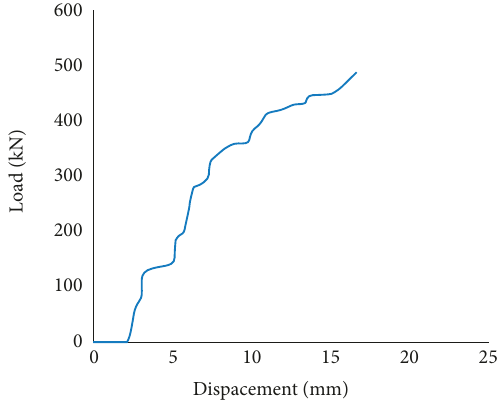
Figure 18: Load-deflection behavior of C specimens strengthened with wrapping.